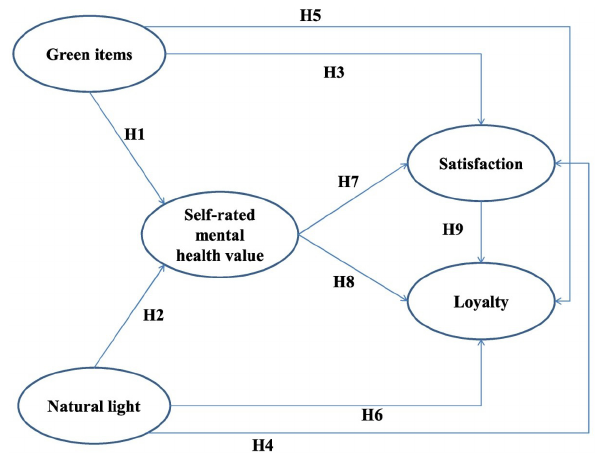
Fig. 1. The research conceptual framework.